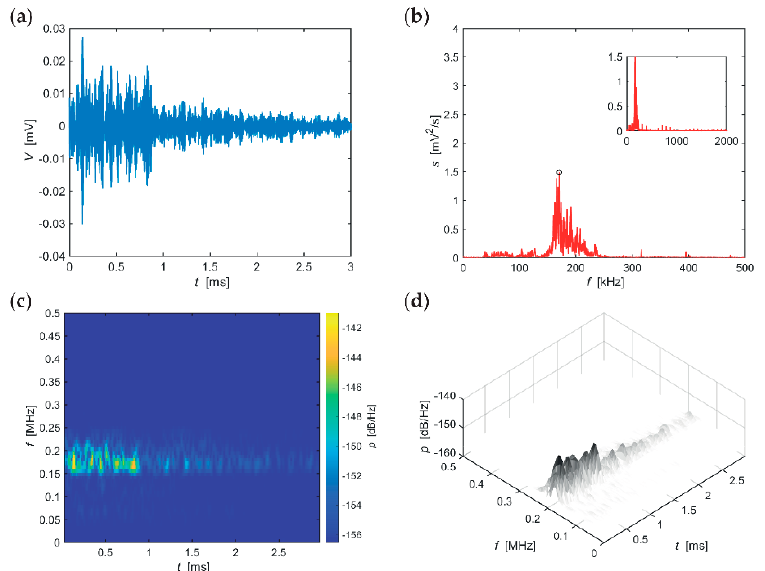
Figure 9. Visualisation of the recorded AE signal during 50–75 F-T cycles from specimens CS150: ( a ) time course of the amplitude, ( b ) frequency spectrum, ( c ) spectrogram STFT-2D image, ( d ) spectrogram STFT-3D image.